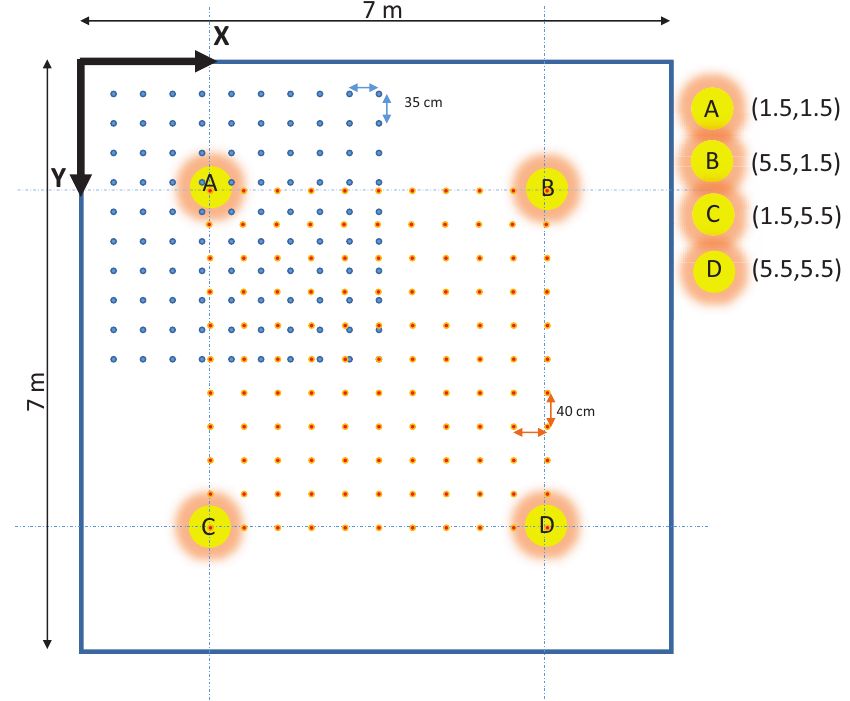
Figure 3. Simulation configuration (A,B,C,D indicate LED locations, blue dots indicate scatter plot ground truth locations, see Section 3.1, orange dots indicate the evaluation points used in Section